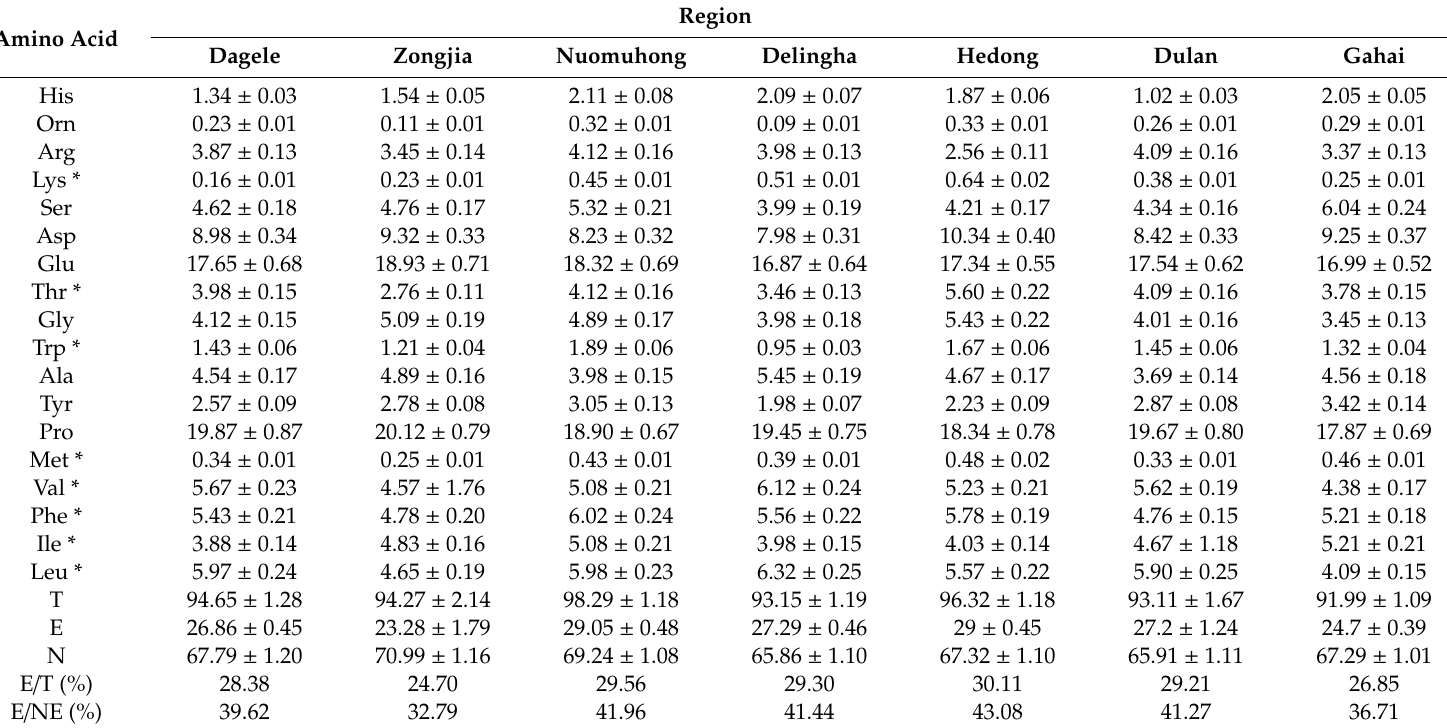
Table 4. The measured contents of amino acids in leaves of Nitraria tangutorum Bobr. (mg / g). Amino Acid